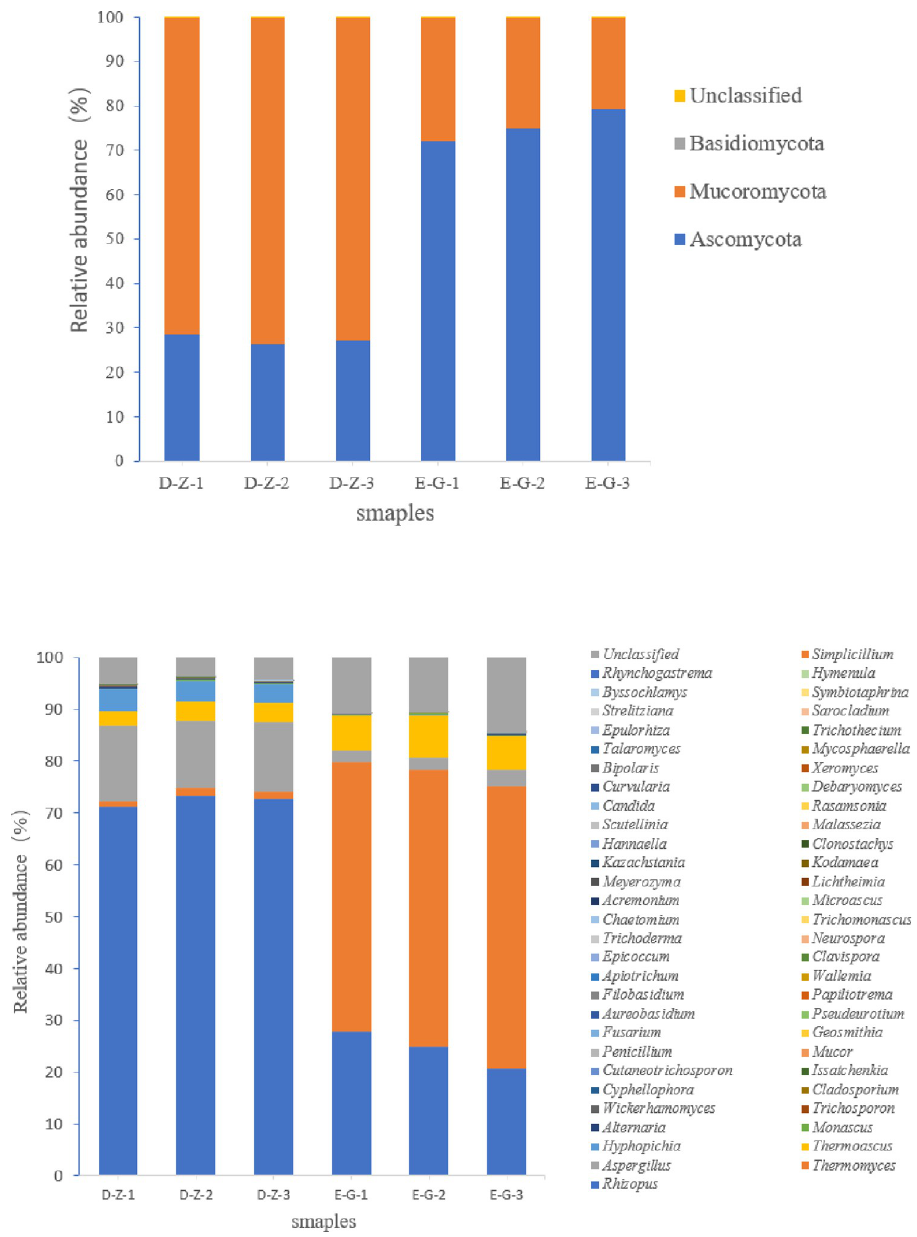
Fig 2. (A) Fungal taxonomy of medium- and high-temperature Daqu at the phylum level. (B) Fungal taxonomy of medium- and high-temperature Daqu at the genus